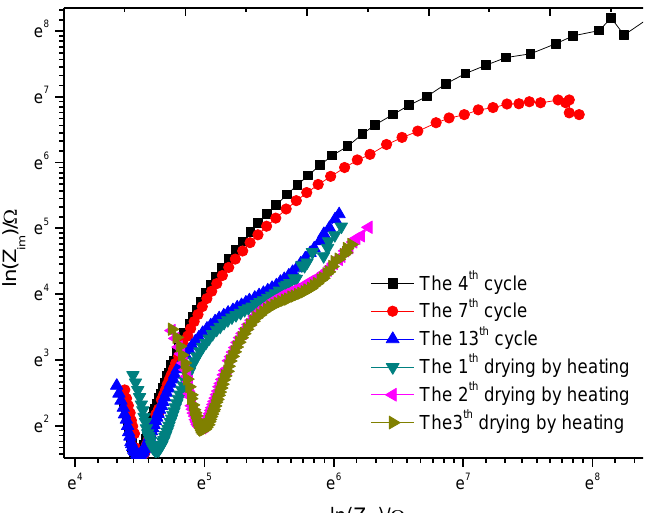
Figure 16. Nyquist plots of monitoring point